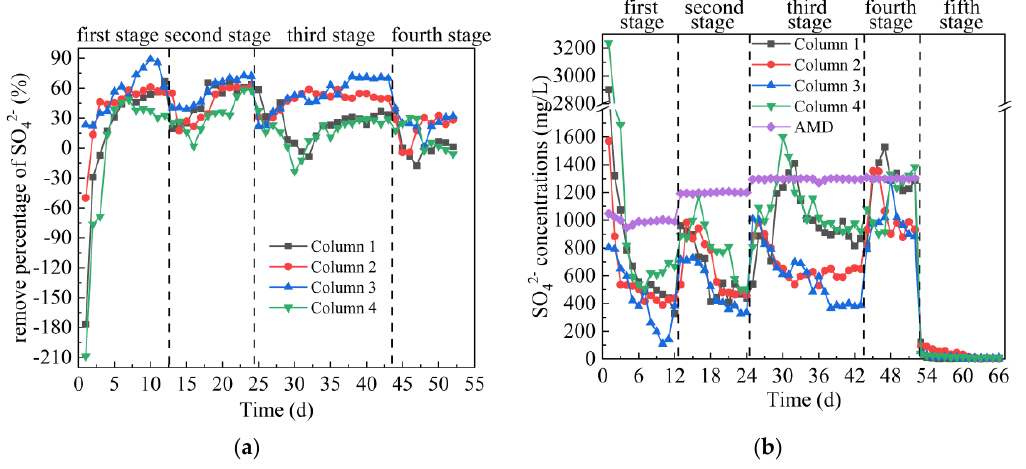
Figure 5. Changes of SO 42− removal effect of SRB combined with Coal Gangue 1–4 to repair AMD. ( a ) SO 42− removal percentage; ( b ) SO 42−